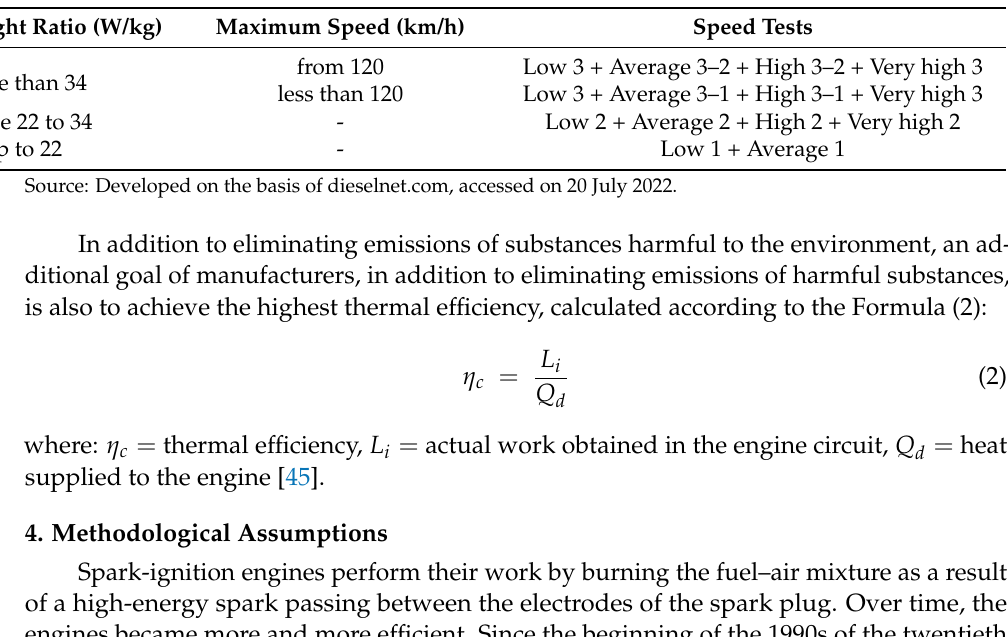
Table 3. Division of vehicles into